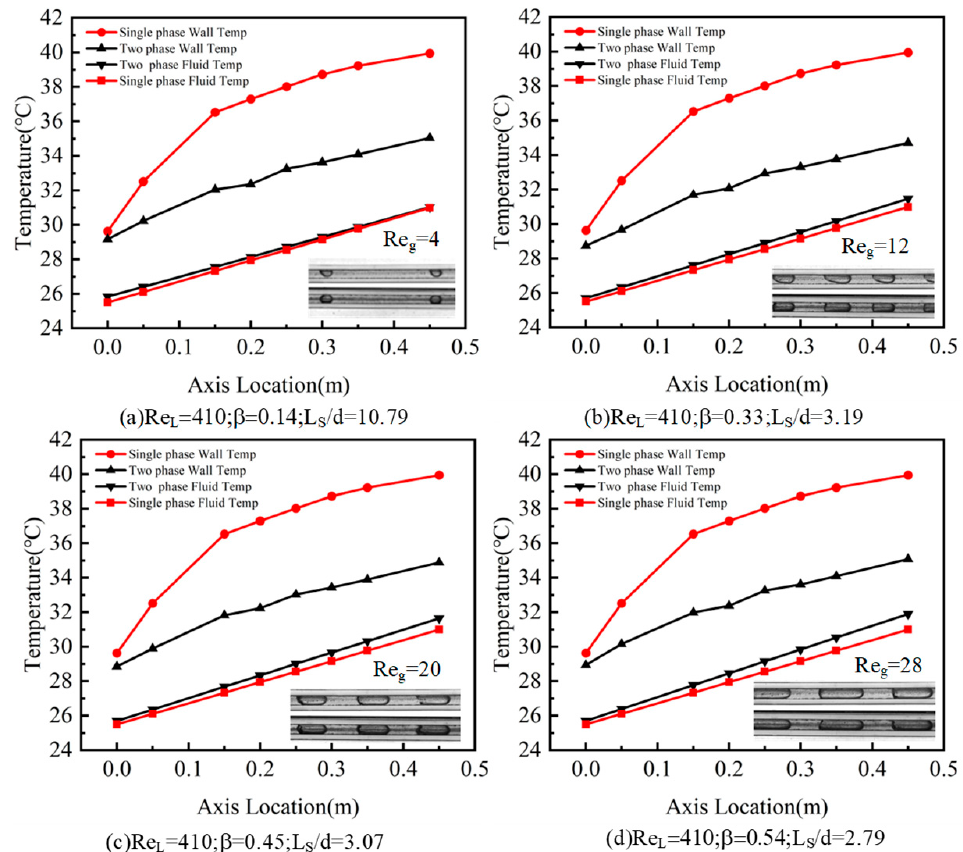
Figure 5. Wall and fluid temperature variations in the square channel in the axial direction: ( a ) Reg = 4; ( b ) Reg = 12; ( c ) Reg = 20; ( d ) Reg = 28.